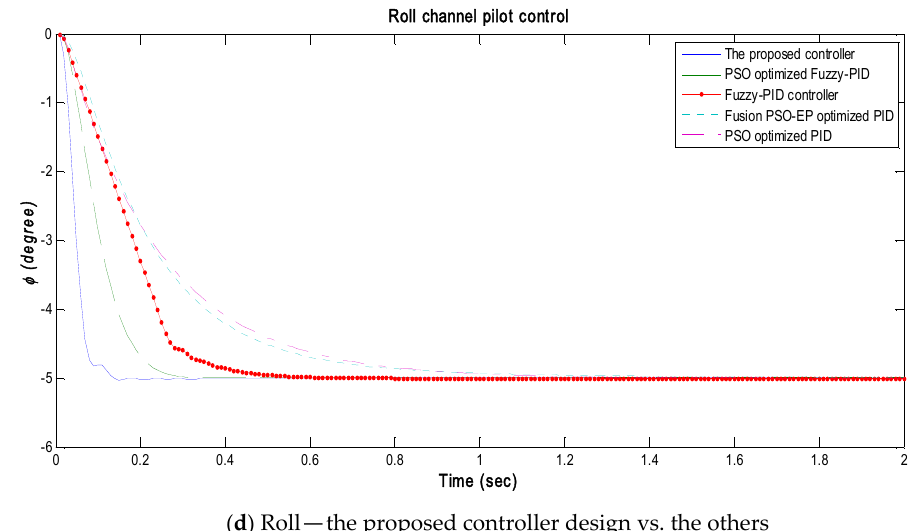
( d ) Roll — the proposed controller design vs. the others Figure 5. Roll channel pilot control. ( a : top left) Fitness function of the proposed controller design. ( b : top right) PID parameter in 3-Dimensions convergence space. ( c : middle) The minimum of IAE(e) and IAE(de) in 2-Dimensions. ( d : bottom) Controllers of the roll angle response.